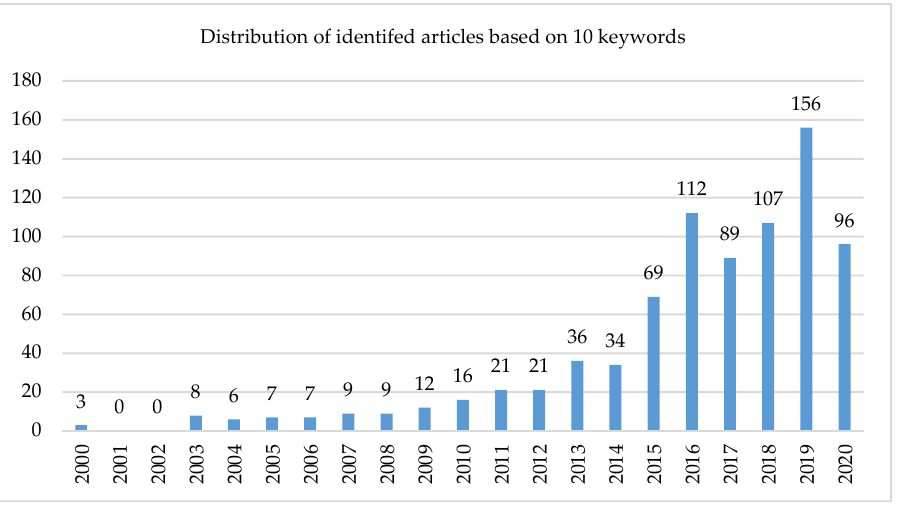
Figure 2. Trend of article distribution based on 818 articles (Identification Phase).